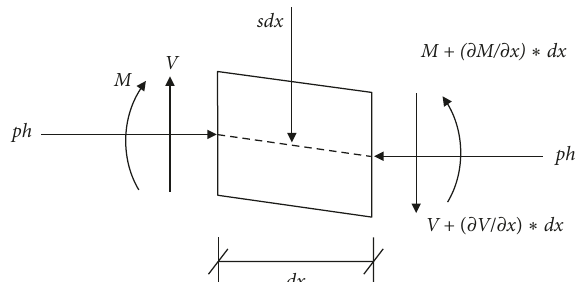
Figure 14: Force analysis of